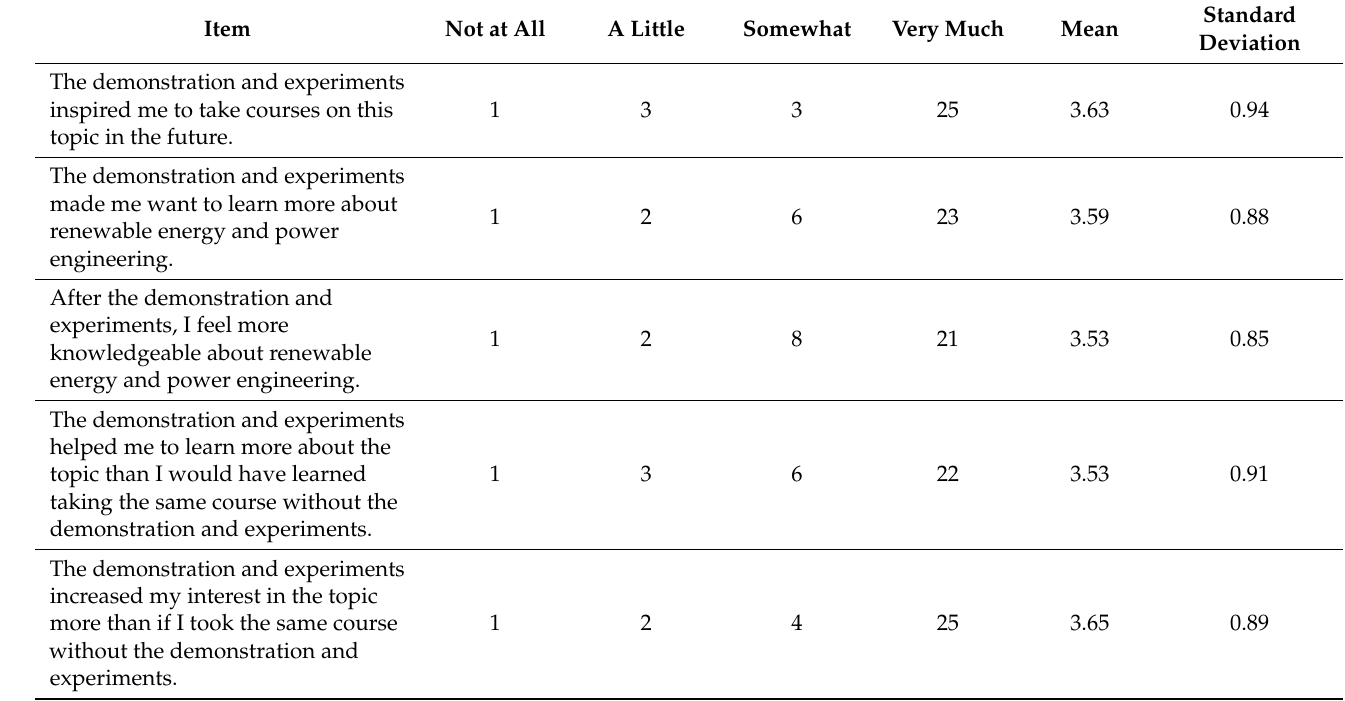
Table 4. Assessment